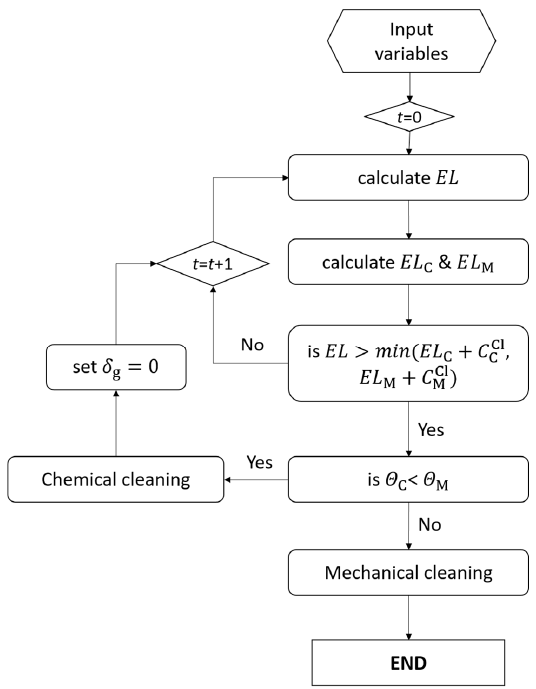
Figure 4. Decisional algorithm.